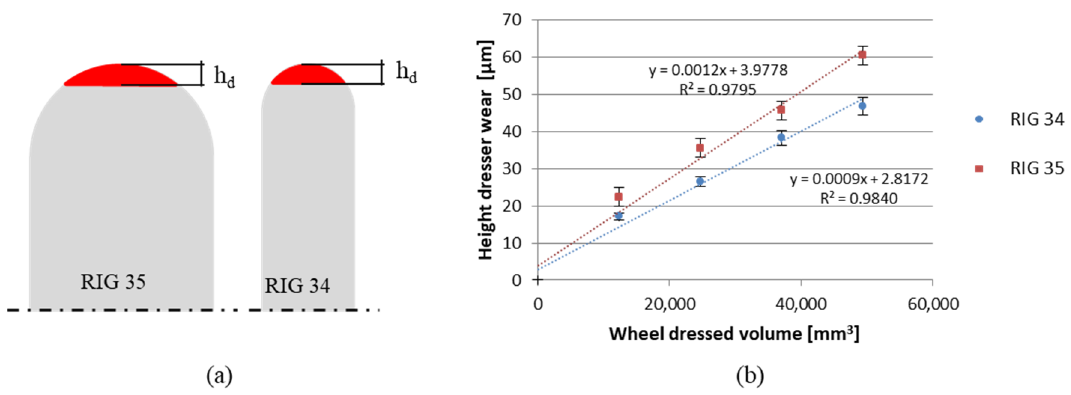
Figure 8 . (a) Dresser comparison and (b) wear height evolution during a complete test.